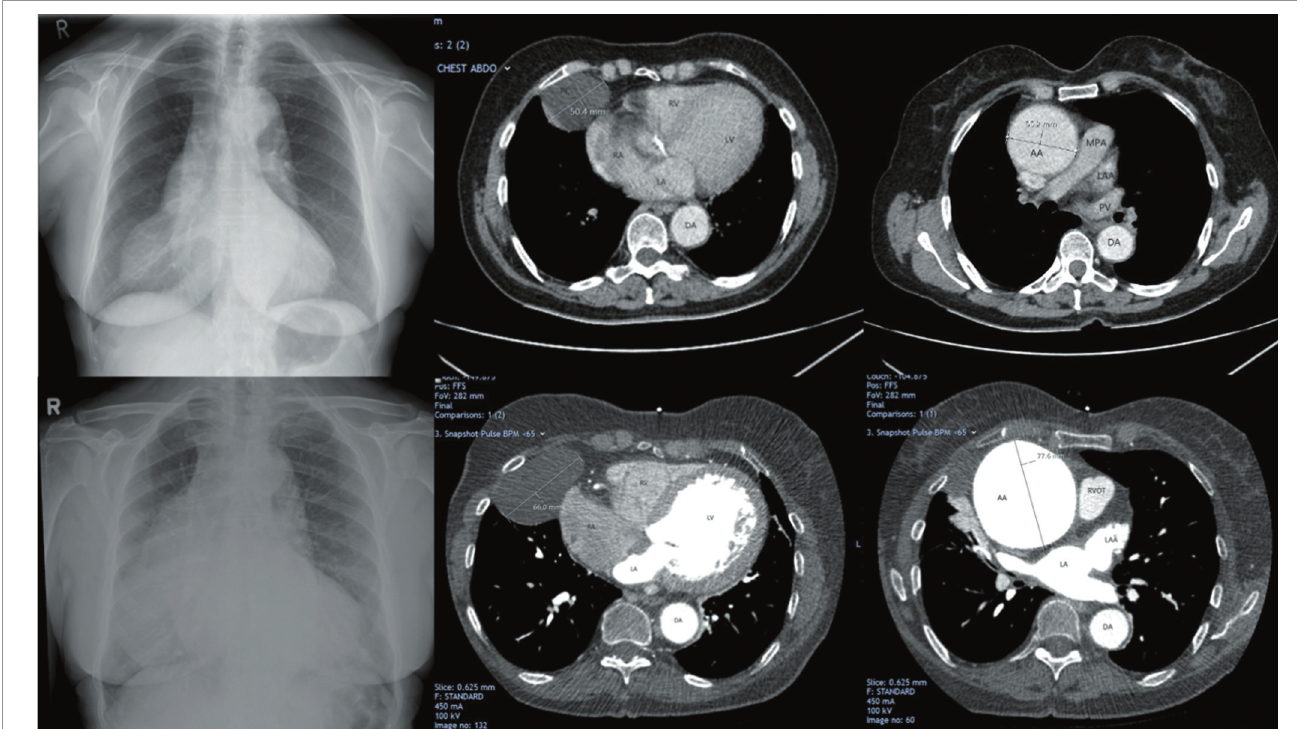
Figure 1. Chest X-ray and CT fi ndings over the course of over 4 years. (A) CXR March 2015, (B) CT showing pericardial cyst measuring 5 cm along the right heart border, (C) CT showing ascending aortic aneurysm measuring 5.5 cm at the aortic root , (D) CXR December 2019, (E) Cardiac gated CT showing pericardial cyst measuring 6.6 cm along the right heart border, and (F) cardiac gated CT showing giant ascending aortic aneurysm measuring 7.7 cm. Abbreviations: AA, ascending aorta; DA, descending aorta; LA, left atrium; LAA, left atrial appendage; LV, left ventricle; MPA, main pulmonary artery; PC, pericardial cyst; PV, pulmonary vein; RA, right atrium; RV, right ventricle; RVOT, right ventricle out fl ow